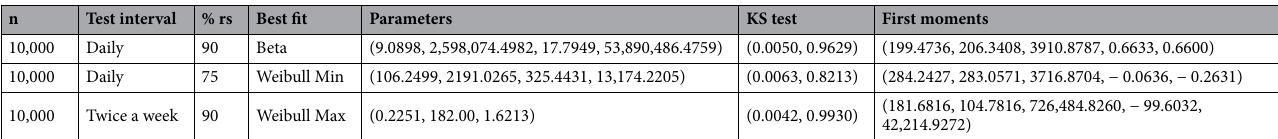
Table 1. Statistics of testing-isolated strategies in the array of (10, 10). Percentage of random sample (% rs). Estimated parameters (a, b, loc, scale). KS goodness-of-fit test (D, p-value). First moments (median, mean, variance, skewness,